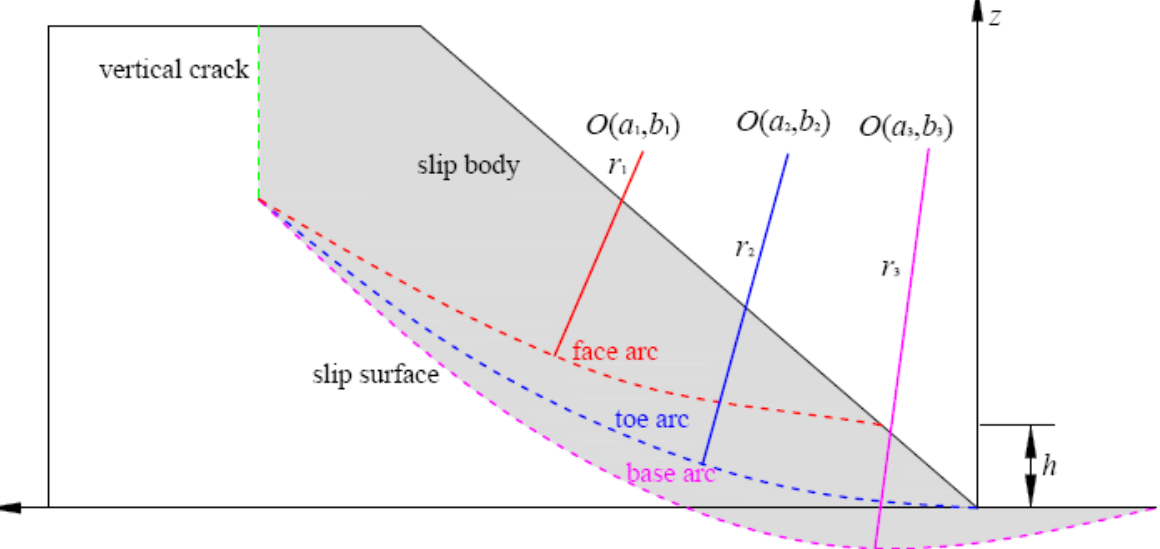
Figure 2. Slope failure mode.